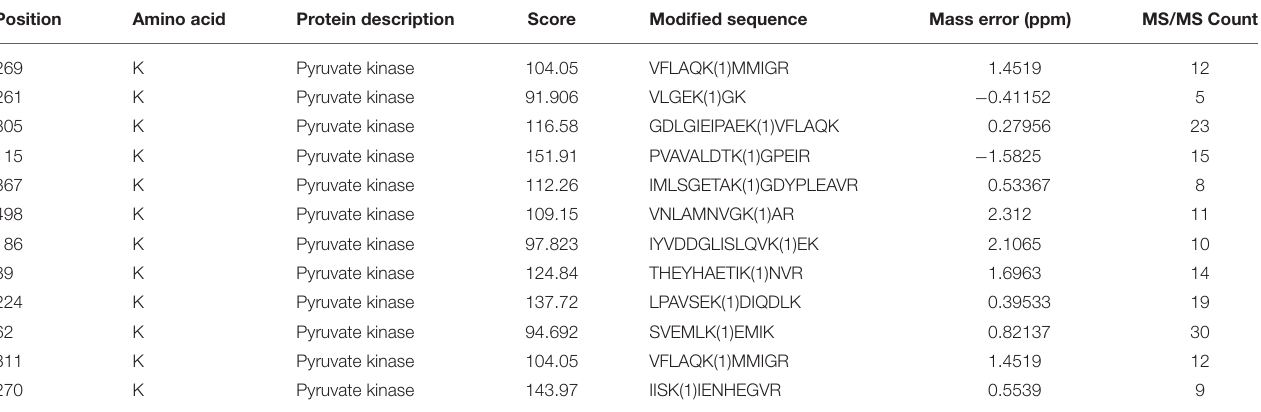
TABLE 3 | Modification site information of pyruvate kinase.